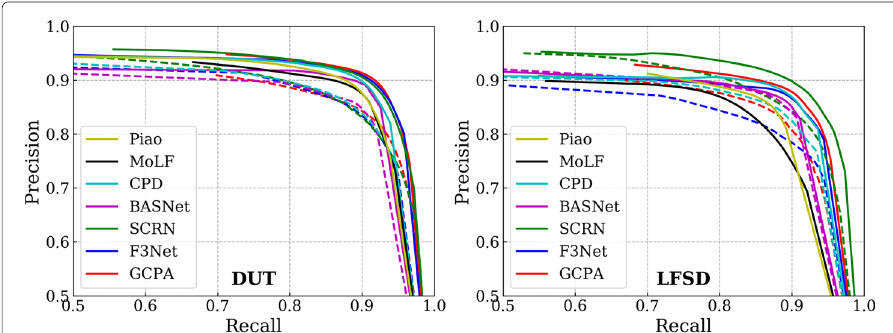
Fig. 6 Comparisons of PR curves on the datasets of DUTLF [7] and LFSD [6]. For a clearer presentation, we select the top five 2D methods with the best overall performance. For 2D methods, the solid lines denote the results by our method while the dash ones denote the results of baseline